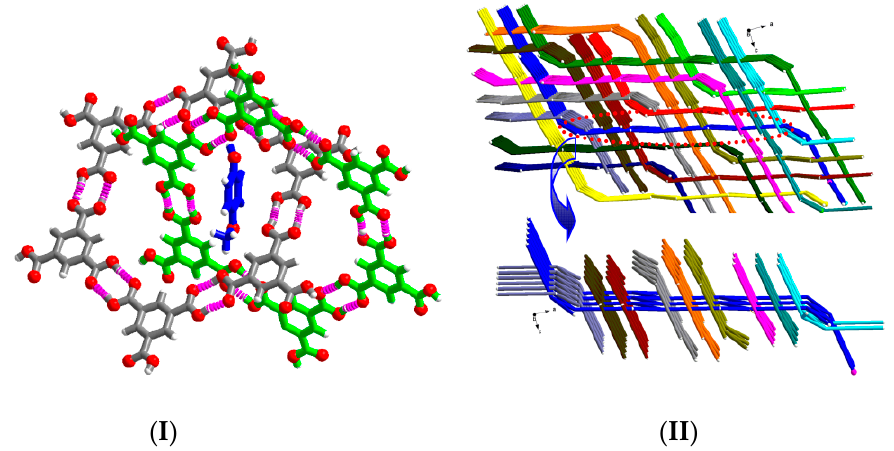
Figure 4. ( I ) MP molecules located in the cavities formed cross hydrogen-bonded 6-rings in compound ( 3 ); ( II ) nine-fold interpenetration of three-dimensional structure along the b axis in compound ( 3 ). Compounds ( 4 ) and ( 5 ) crystallized from a methanol solution in a 1:1 ratio in an asymmetric unit cell. Single-crystal X-ray diffraction reveals that both compounds ( 4 ) and ( 5 ) crystallize in a monoclinic cell with the C 2/c space group. Unlike compounds ( 1 )–( 3 ), EP/PP replaced two TMA molecules and interconnected to form a tetragonal hole through O − H···O hydrogen bonding as shown in Figure 5II. The tetragonal holes further interact with each other to form one-dimensional chains (Figure 6).